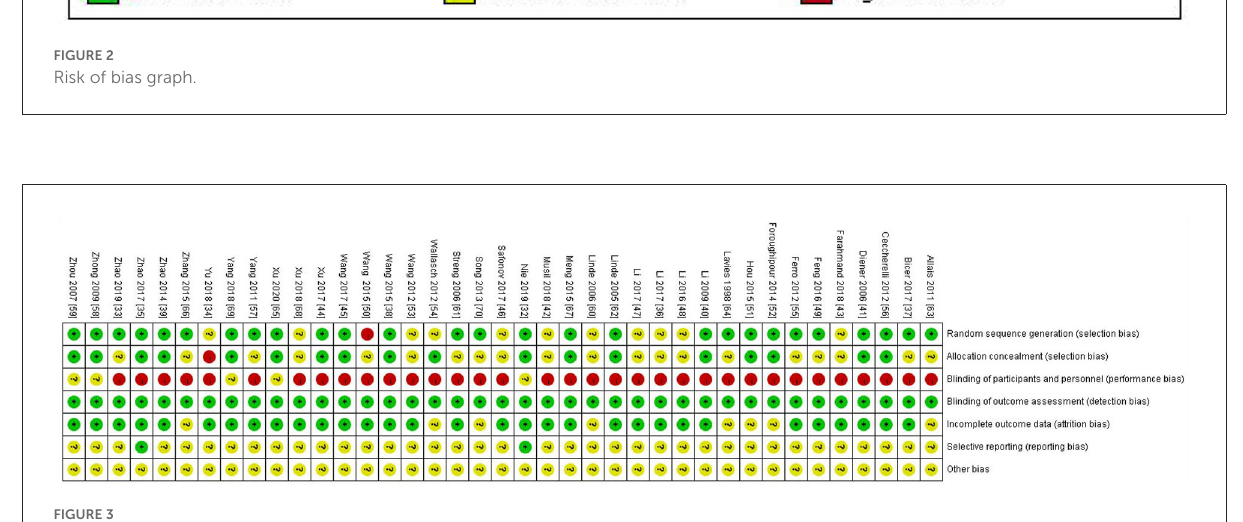
FIGURE3 Risk of Bias